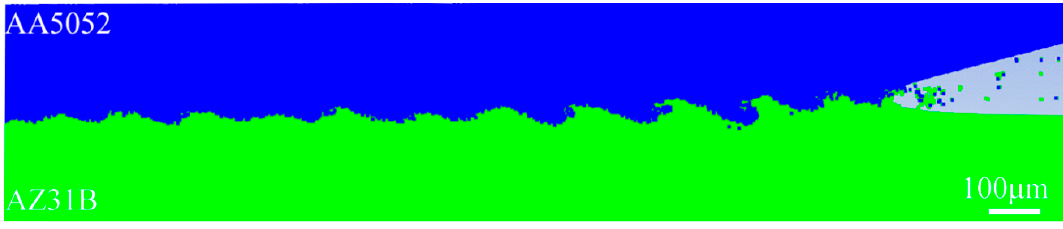
Figure 9. Interfacial morphology obtained using the SPH method.